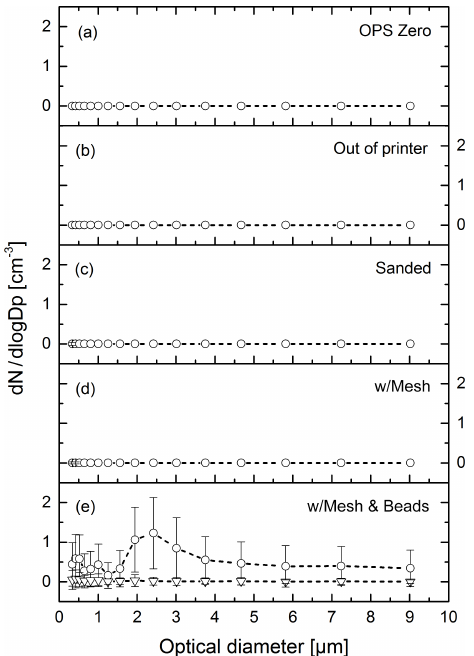
Figure 4. Time-series measurements of particle number concentra- tions: (a) CPC with filter; (b) freshly printed generator; (c) through the generator after wet sanding; (d) through the generator after wet sanding and installing the porous screen; (e) fully assembled gener- ator including porous screen and bronze beads atop as bed material, without (solid line) and with a stainless steel insert (dashed line).